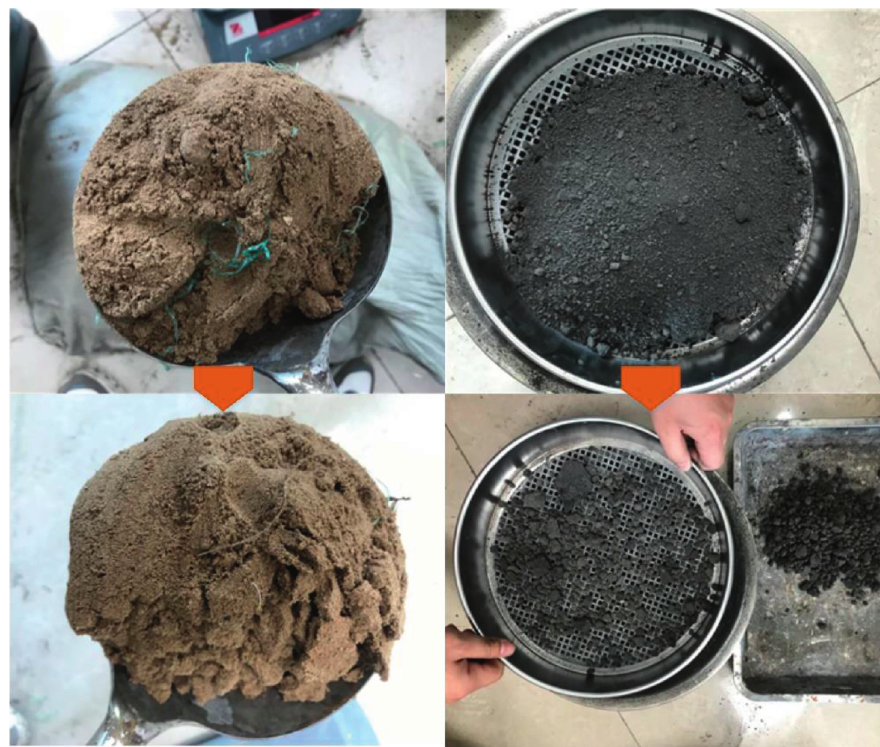
Figure 2: YRS pretreatment and CG